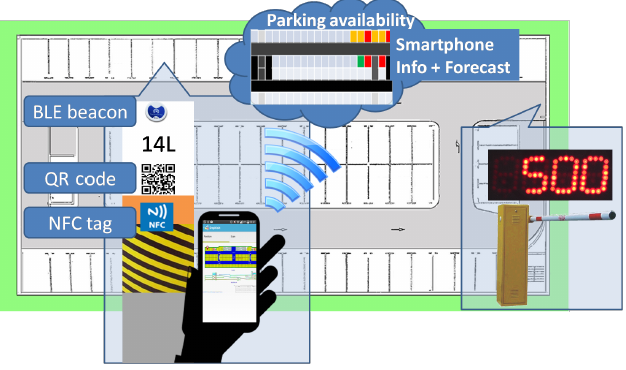
Figure 3. Low-cost indoor parking